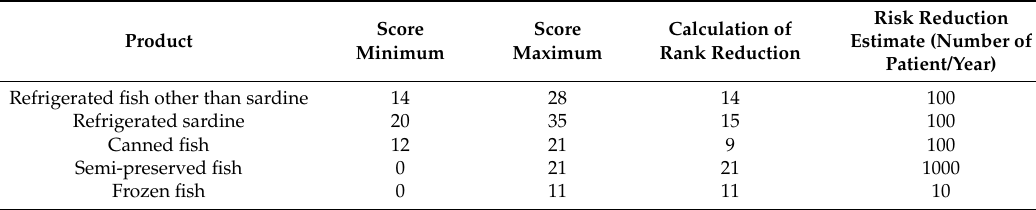
Table 2. Estimated risk reductions for each product